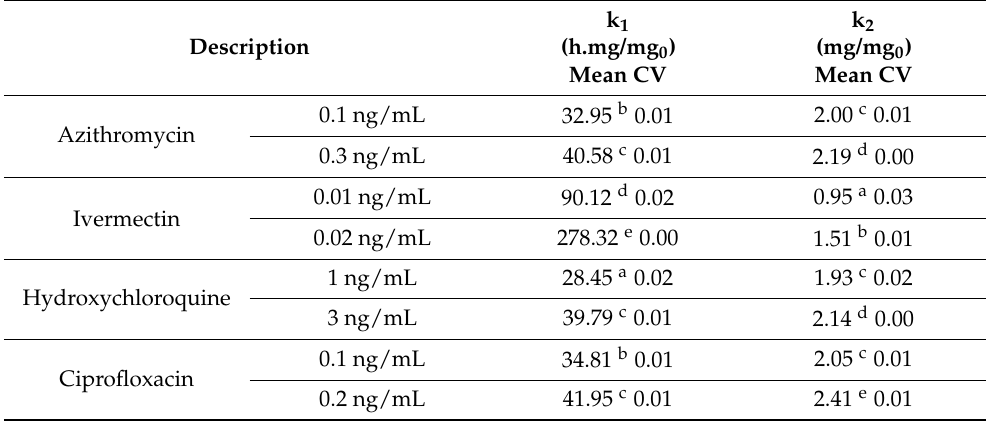
Table 2. Peleg’s constants of the diffusion of monomeric anthocyanin content during the fermentation process.